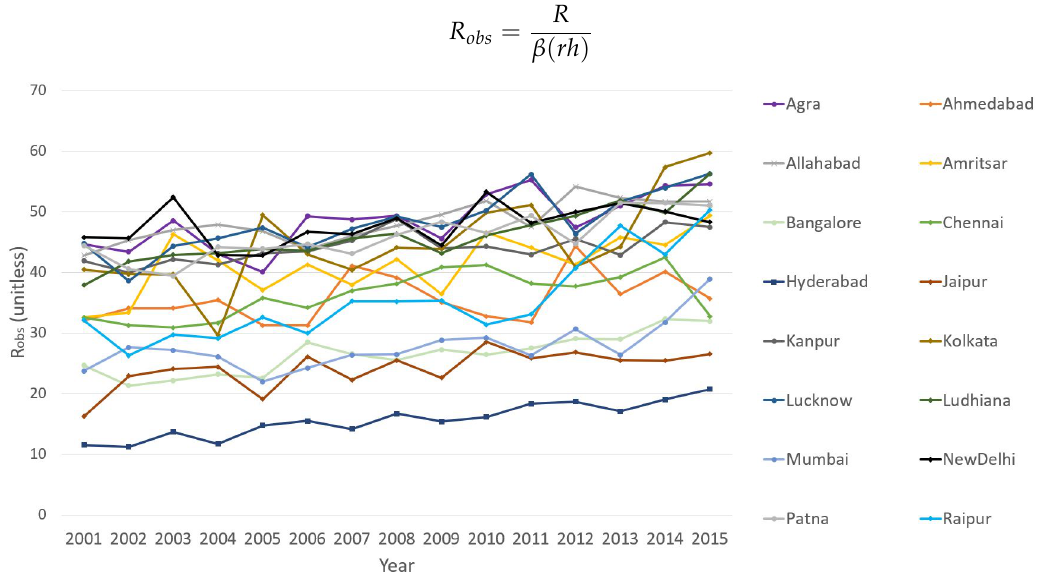
Figure 3. Annual R values show an increasing trend for the 15 locations under study in this